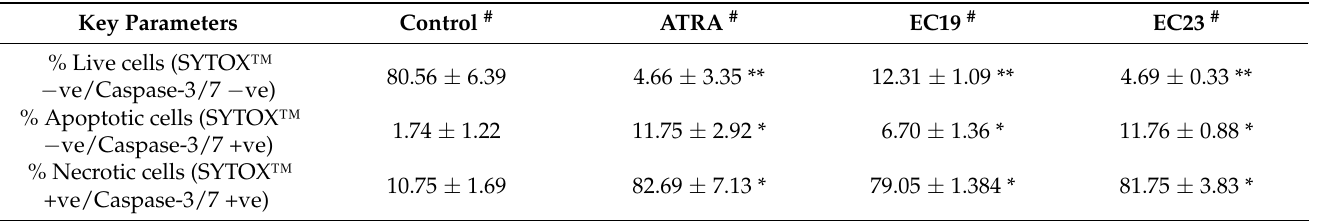
Table 4. Distribution of Caco-2 cell populations after exposure to individual retinoids as detected by